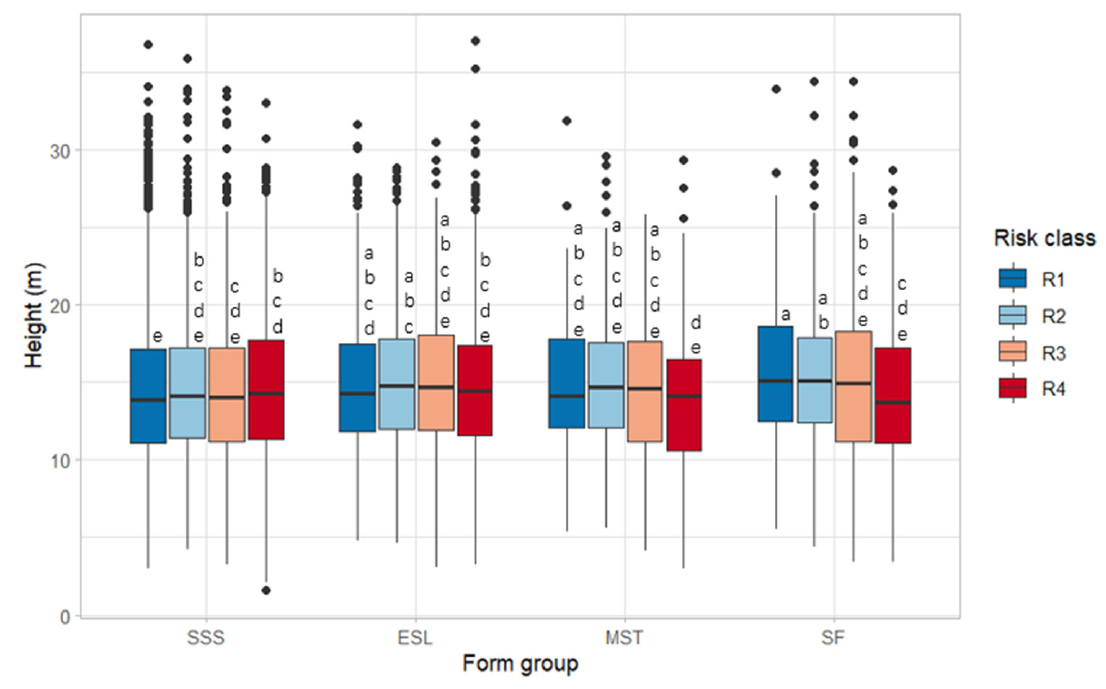
Figure 11. Tree height (m) depending on form group (SSS: single straight stem, ESL: extensive sweep or lean, MST: multiple stems and SF: significant fork).and risk class (R1–R4) (N = 24,048). Different letters indicate statistically different heights between risk classes based on Tukey-HSD post hoc